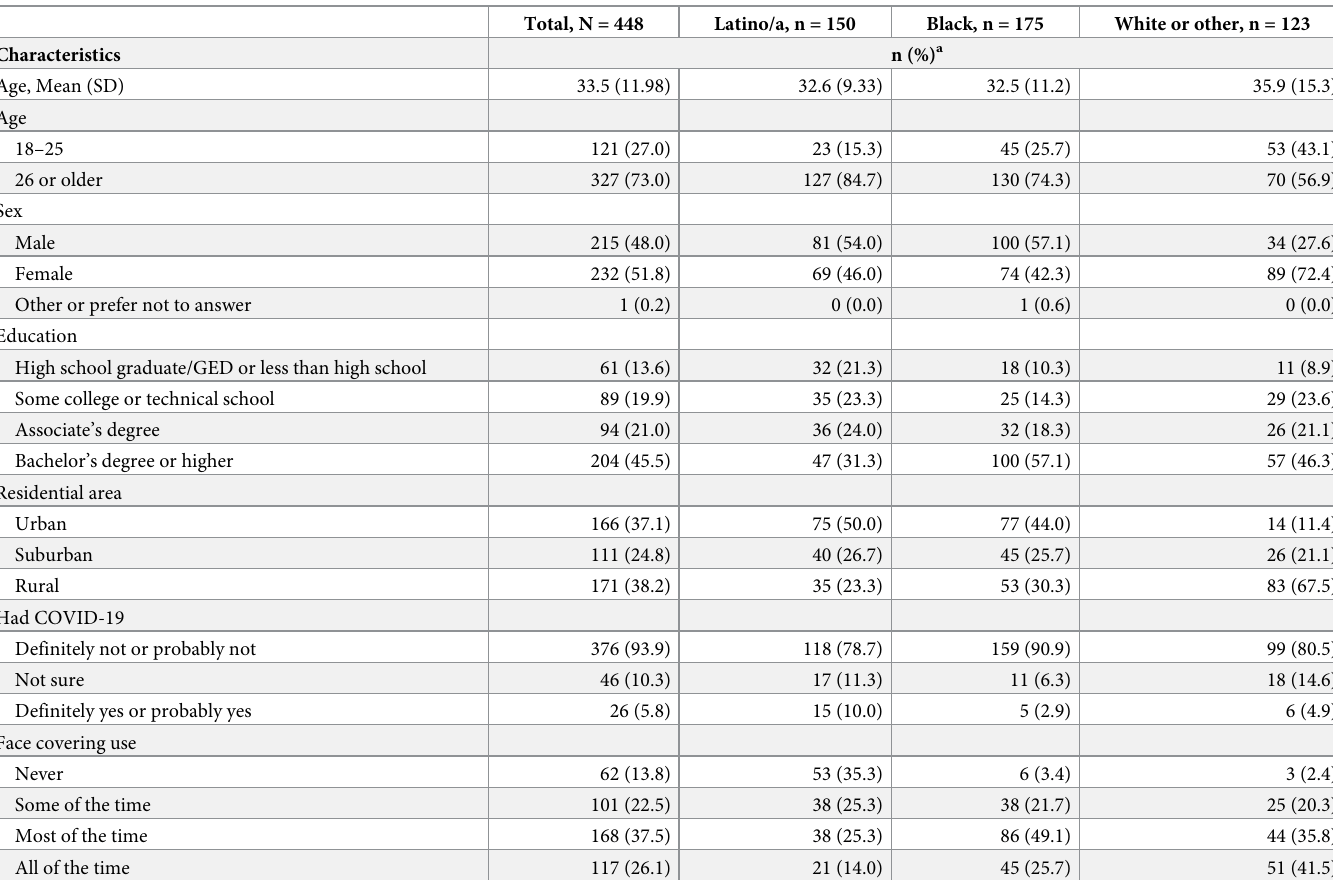
Table 1. Characteristics of survey participants by race and